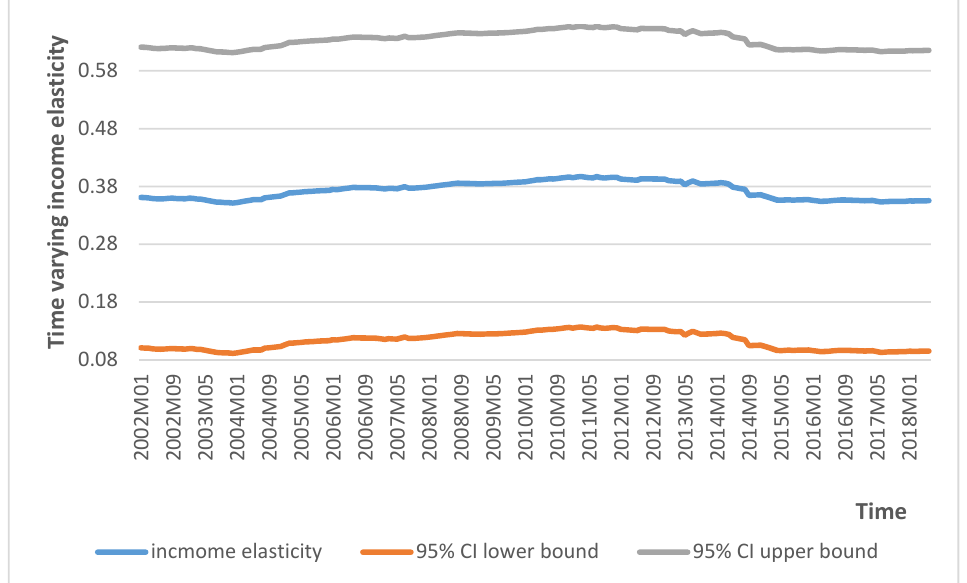
Figure 4. Time varying income elasticity: STSM result.